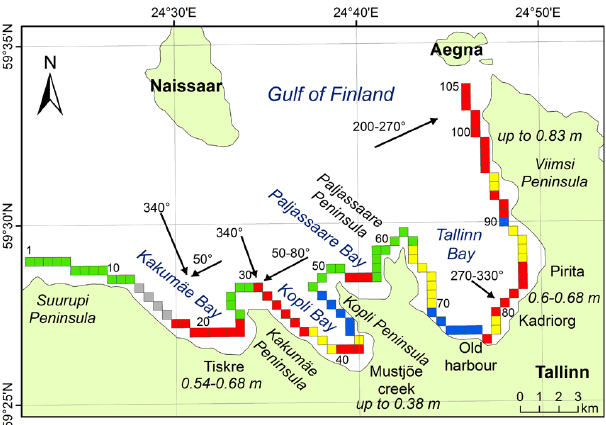
Fig. 10. Areas around Tallinn potentially affected by high wave set-up (red squares indicate the maximum set-up) with the respec- tive directions of wave propagation (arrows). Yellow squares in- dicate coastal stretches where the maximum wave set-up is less than 20cm, green squares indicate areas where high set-up is ev- idently not possible because of the convex shape of the coastline, grey squares indicate areas naturally protected by a cliff and blue squares represent areas containing various engineering